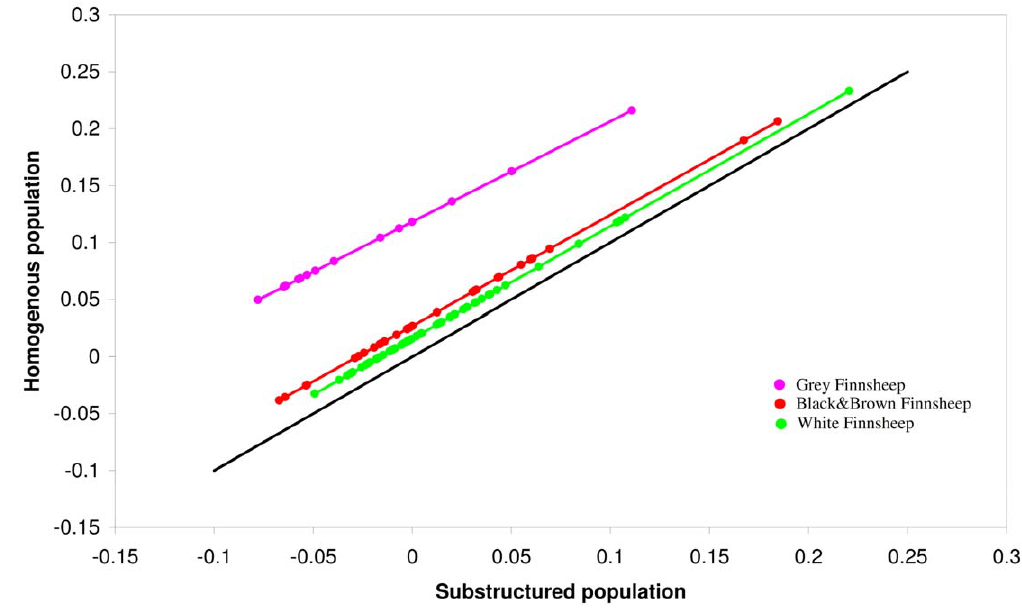
Figure 4. Genomic estimations of Inbreeding coefficient ( F SNP ) in a substructured population plotted against those of a homogeneous population. The black line follows the expectation that inbreeding coefficients are the same under the two situations. doi:10.1371/journal.pone.0026256.g004 be 1 st degree relatives (e.g. full-sibs), 36 pairs to be 2 nd degree relatives (e.g. half-sibs), and 125 pairs to be 3 rd degree relatives (e.g. first cousins; see Table S1). Of a total of 2321 positive values for the between-group kinship coefficient obtained based on the pedigree information ( F PED ) were compared with those calculated pedigree data, 278 were from the pairs in grey vs. white, and 261 using SNP data ( F SNP ) in a homogeneous population or in the were from the pairs in grey vs. black or brown. presence of population substructure (Fig. 5). The regression of F